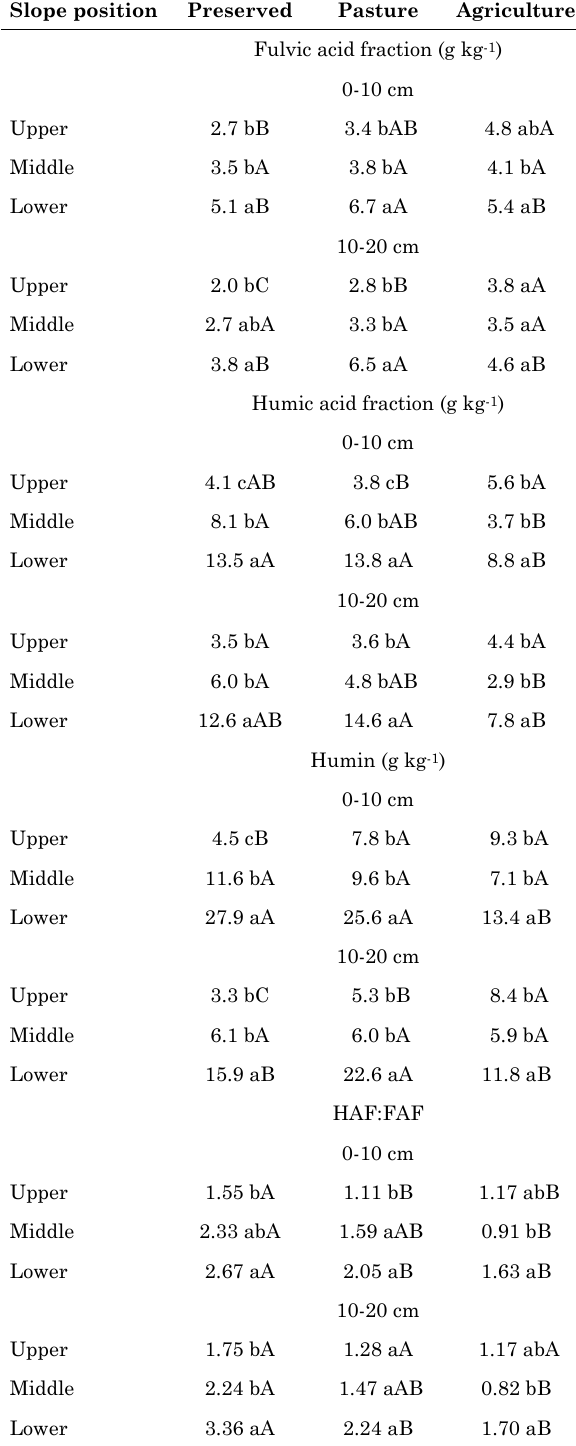
Table 4. Carbon of humic fractions of soil organic matter at different slope positions and influenced by different land uses of the surrounding areas, in the 0-10 and 10-20 cm layers Slope